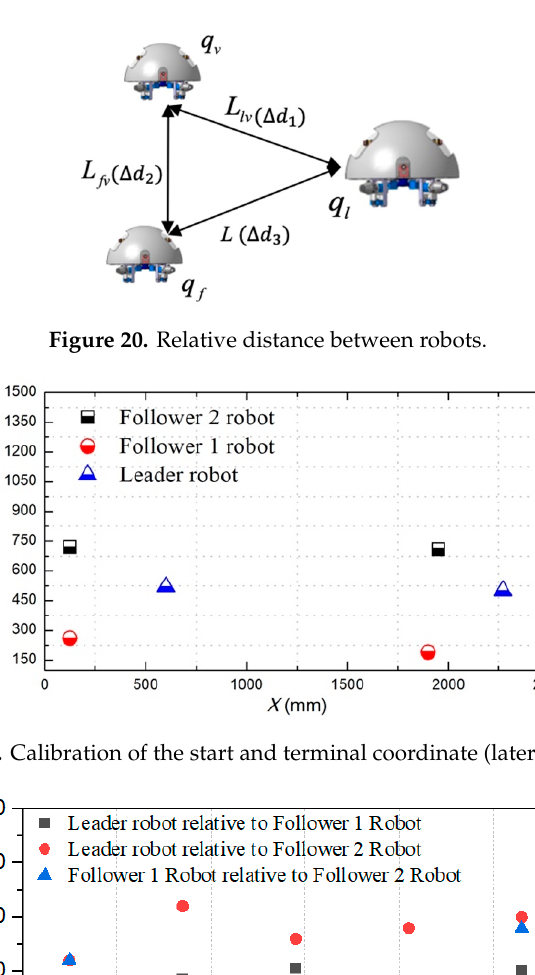
d Δ is the relative distance between two